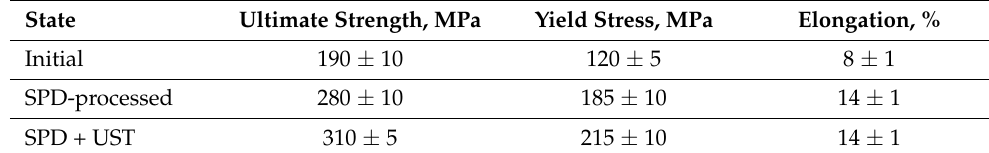
Table 2. Mechanical properties of Mg–Al–Zn alloy in different structural states [101]. State Ultimate Strength, MPa Yield Stress, MPa Elongation, %